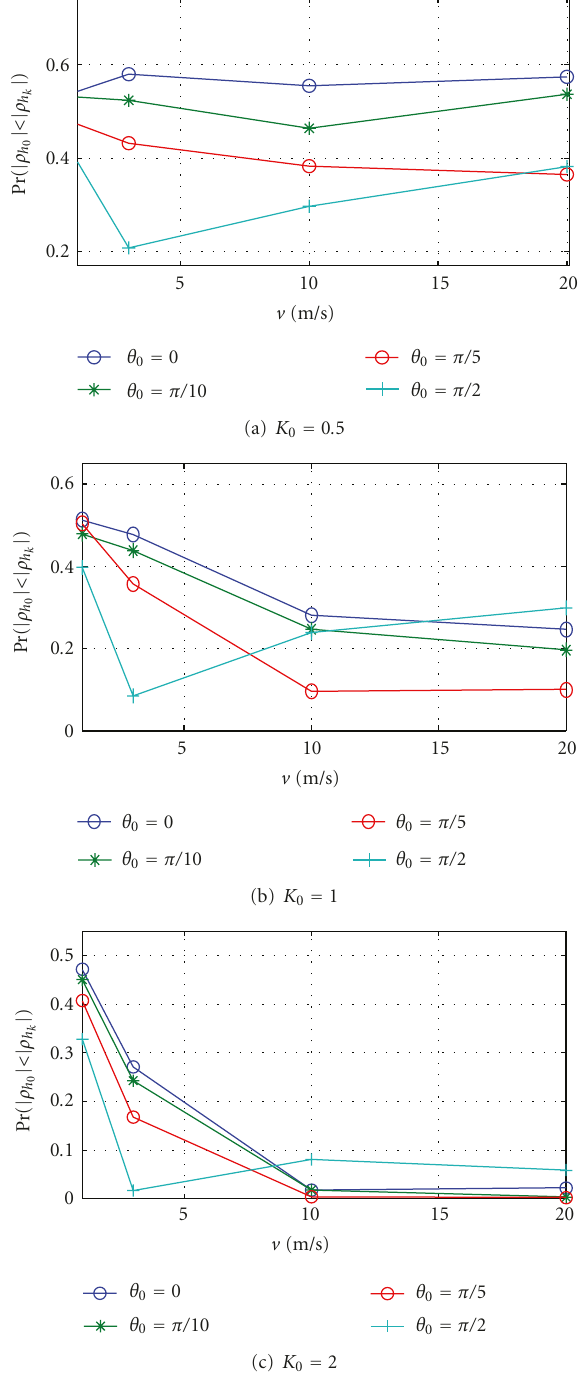
Figure 6: The probability of | ρ h mobile speed for di ff erent AoAs under the assumption of Case 1 along with underlying process (I).